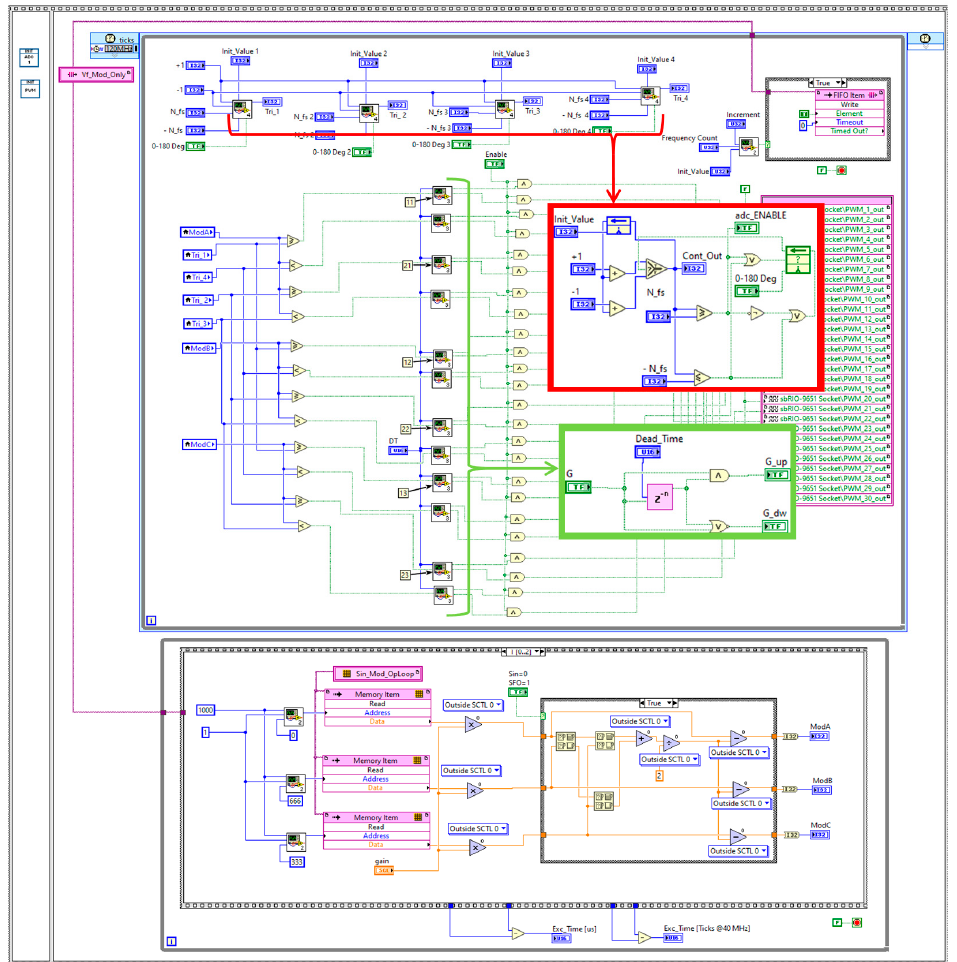
Figure 9. Block diagram of FPGA target including generation of carriers, modulating signals, and PWM signal.